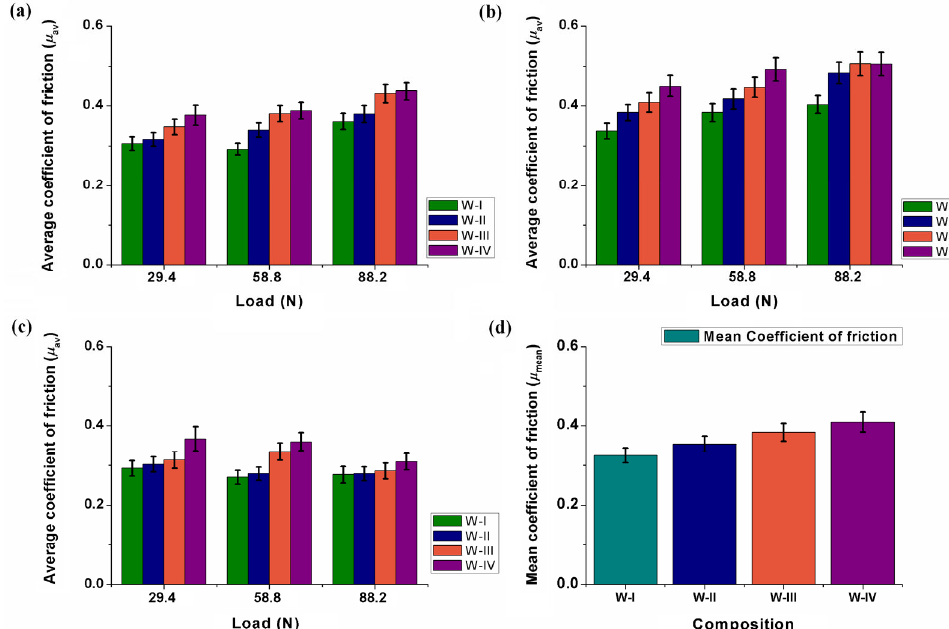
Fig. 9 Average coefficient of friction at (a) 0.2 m/s, (b) 1.8 m/s, and (c) 3.3 m/s. (d) Mean coefficient of